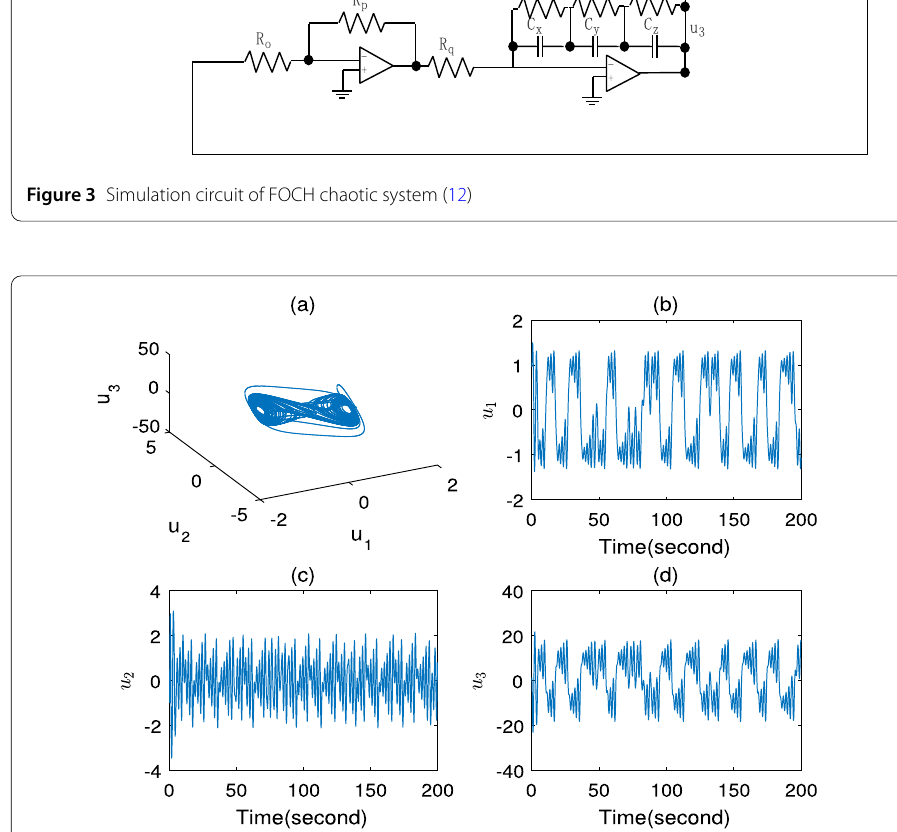
Figure 4 Dynamical behavior of system (12) with ω ( s ) = 0